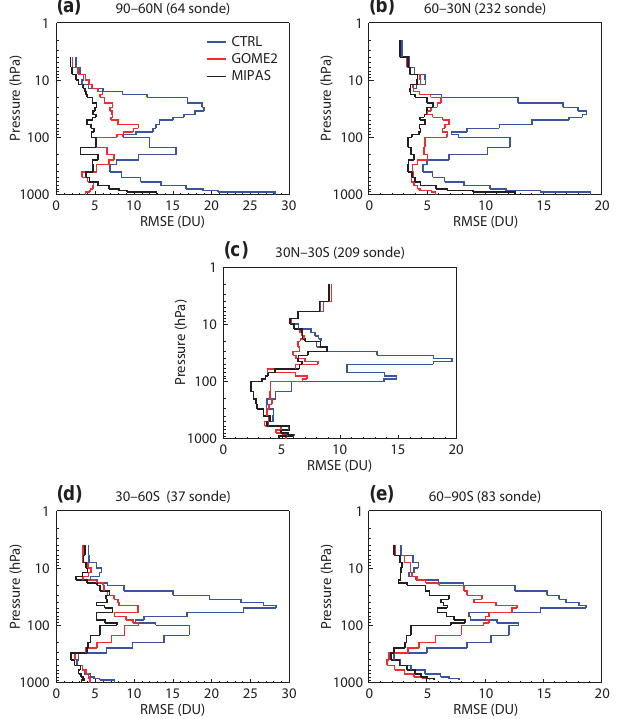
Figure 12. Fit of the ozone analyses from three experiments to ozone sondes given in terms of the RMSE over five latitudinal bands (one per panel as follows: 90–60 ◦ N in panel a , 60–30 ◦ N in panel b , 30 ◦ N–30 ◦ S in panel c , 30–60 ◦ S in panel d , and 60– 90 ◦ S in panel e ). The comparisons were computed by averaging over August–October 2008. The three analyses were taken from Exp/Ctrl (blue lines) and the two Exp/PERT experiments, assimi- lating also the reprocessed GOME-2 NPO 3 (red lines) and MIPAS LPO 3 (black lines) from the O3-CCI. The latitudinal band each panel refers to and the number of ascents included in the average can be found in the corresponding panel title. Data are in Dobson Unit